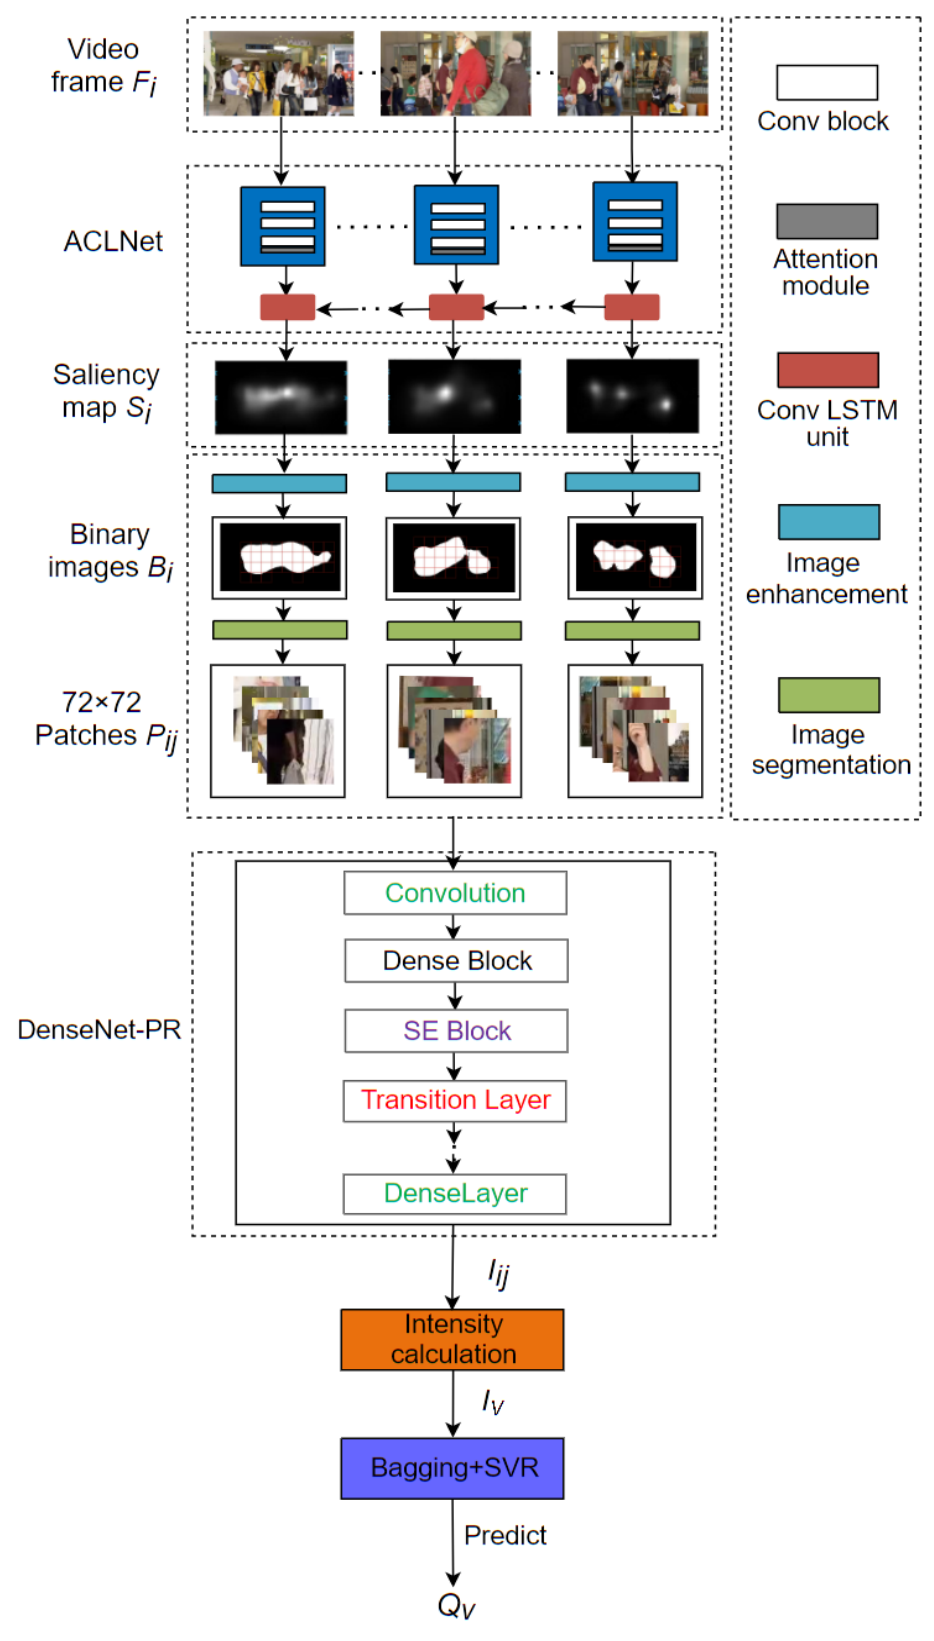
Figure 1. The overall architecture of